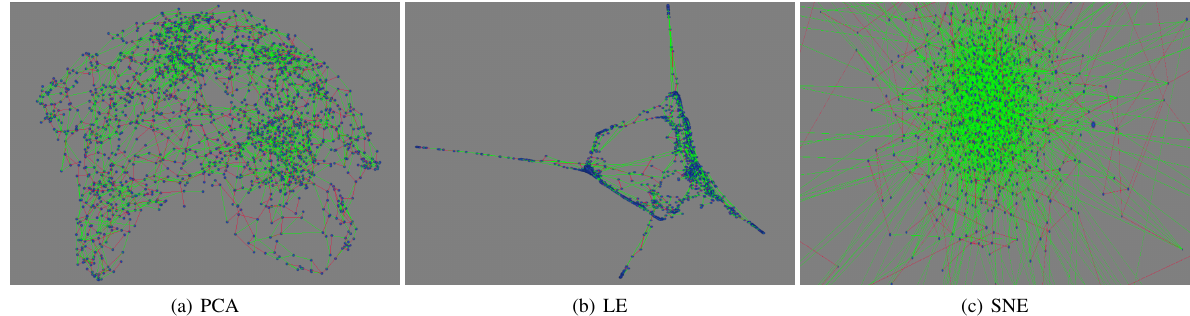
Figure 7: The MST of neighborhood graph of the face data points before and after dimension reduction. The green and red lines show the edges of trees before and after dimension reduction, respectively.